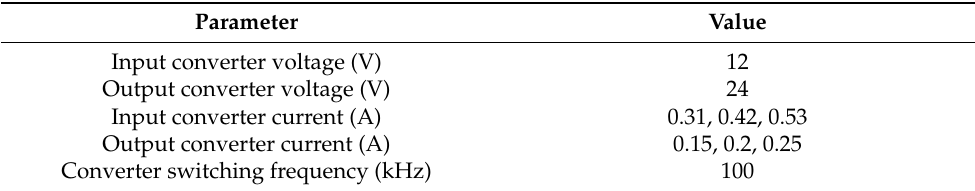
Table 5. Operational Parameters of the Boost Converter during the Tests.